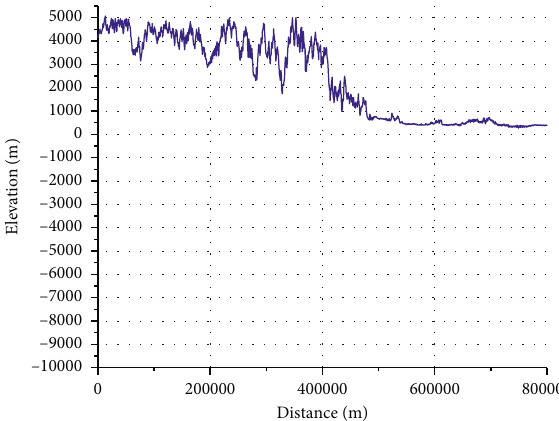
Figure 12: Velocity distribution in the z direction.